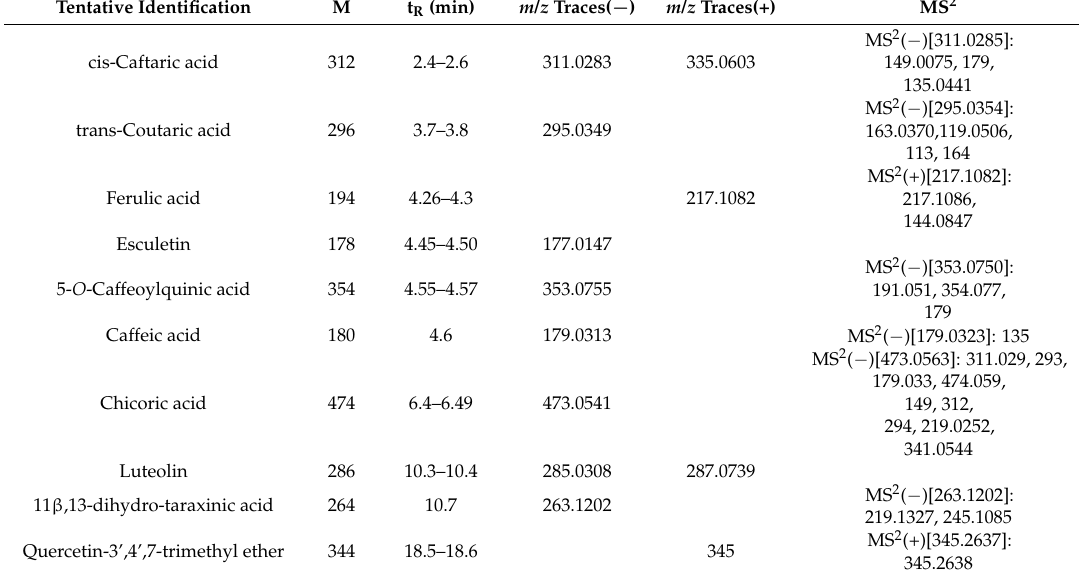
Table 1. Composition of ETOW.